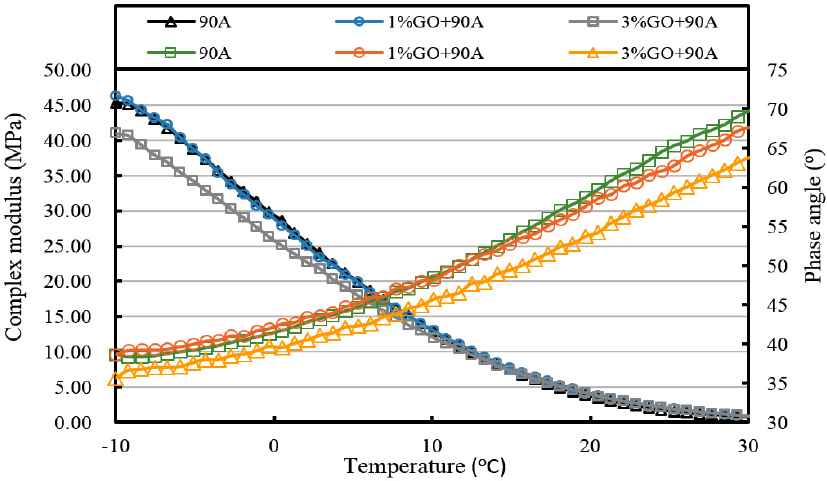
Figure 14. Complex modulus and phase angle of GO-modified 90A and its matrix at low temperature before aging.